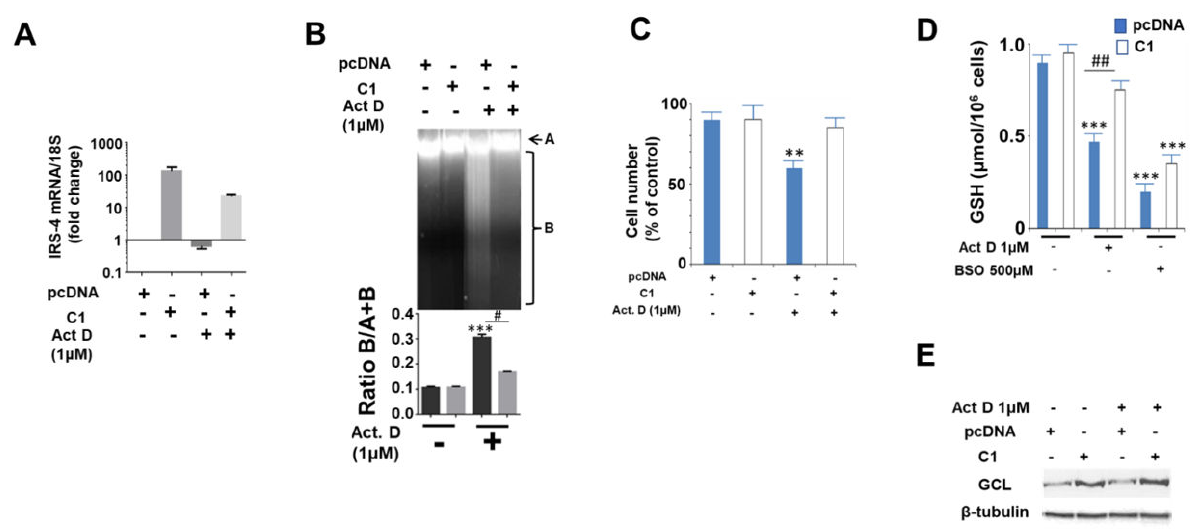
Figure 5. Effect of IRS-4 overexpression on HepG2 cell death induced by ActD. ( A ) IRS-4 mRNA expression levels in C1 and pcDNA colonies obtained from the HepG2 cell line and incubated with Act D (1 µ M) for 24 h. ( B ) DNA fragmentation of C1 and pcDNA colonies after treatment with ActD (1 µ M) for 24 h. The experiment is representative of three others. ( C ) Number of cells in colonies C1 and pcDNA of HepG2 after treatment with ActD (1 µ M) for 24 h. ( D ) Glutathione levels in C1 and pcDNA colonies after treatment with ActD (1 µ M) for 24 h. BSO has been used as a control for inhibition because it is a specific competitor of glutamyl cysteinyl ligase (GCL). ( E ) Glutamyl cysteinyl ligase (GLC) levels assessed by immunoblot in C1 and pcDNA colonies after treatment with ActD (1 µ M) for 24 h. β -tubulin was used as a loading control of SDS-PAGE. The western blotting experiments are representative of three others with similar results. Significance levels: ** p < 0.01; *** p < 0.001; ## p <